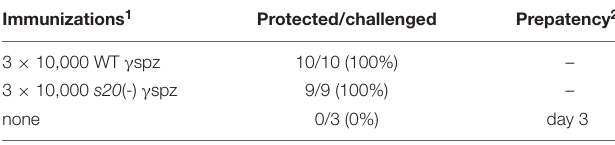
TABLE 1 | Vaccine-induced protection against WT sporozoite challenge infections.